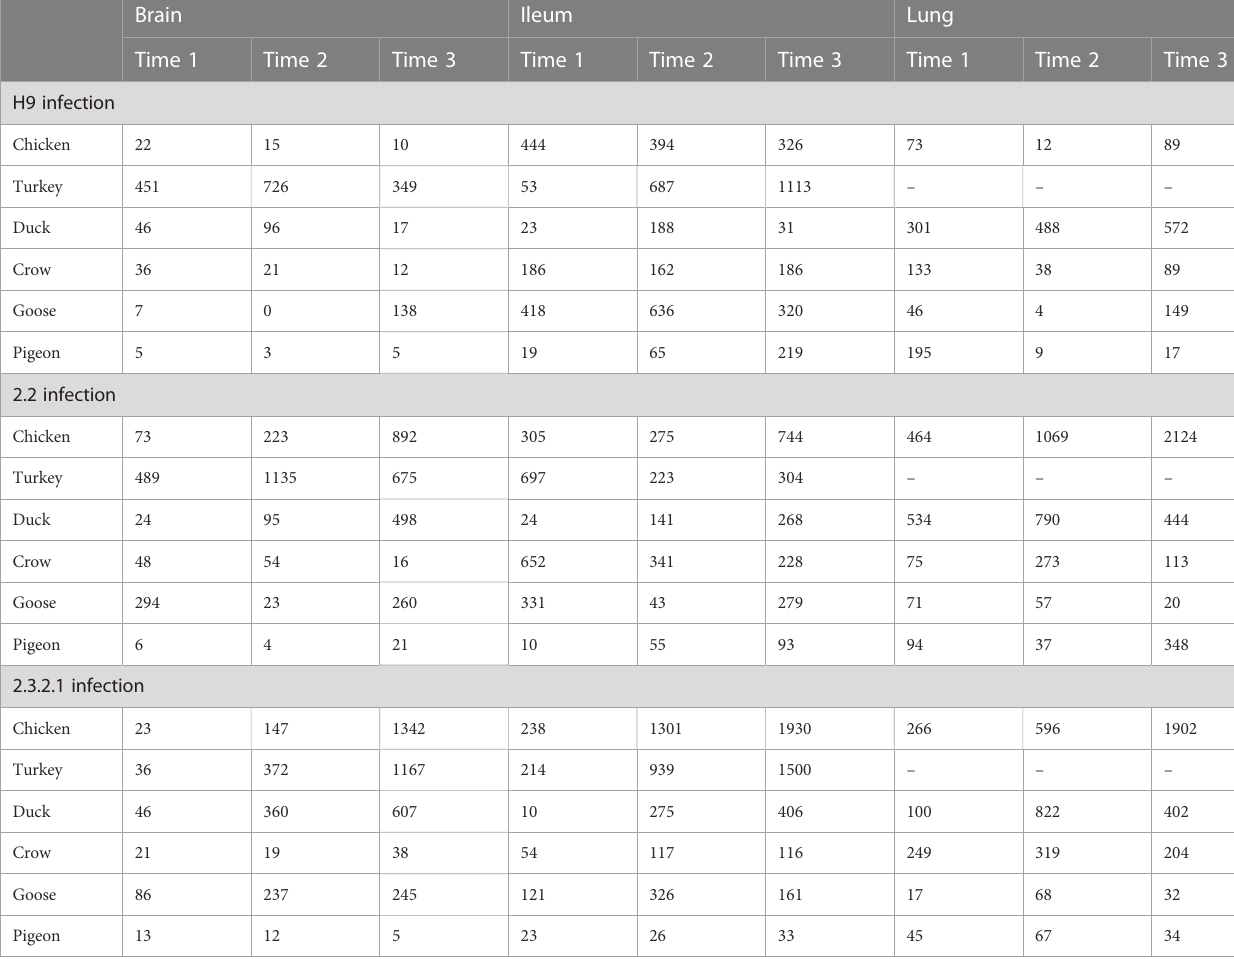
TABLE 2 Number of DEGs in each treatment group (LogFC >1.5, FDR <